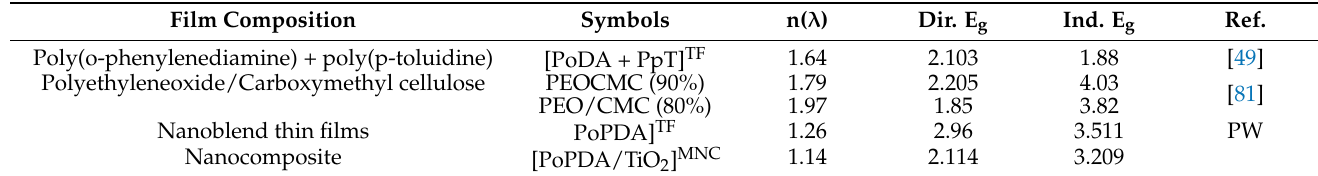
Table 4. Refractive index n( λ ), direct and indirect energy gaps ( ∆ E ) values for nanofiber PoPDA] TF and [PoPDA/TiO 2 ] MNC. thin films and comparison with a different